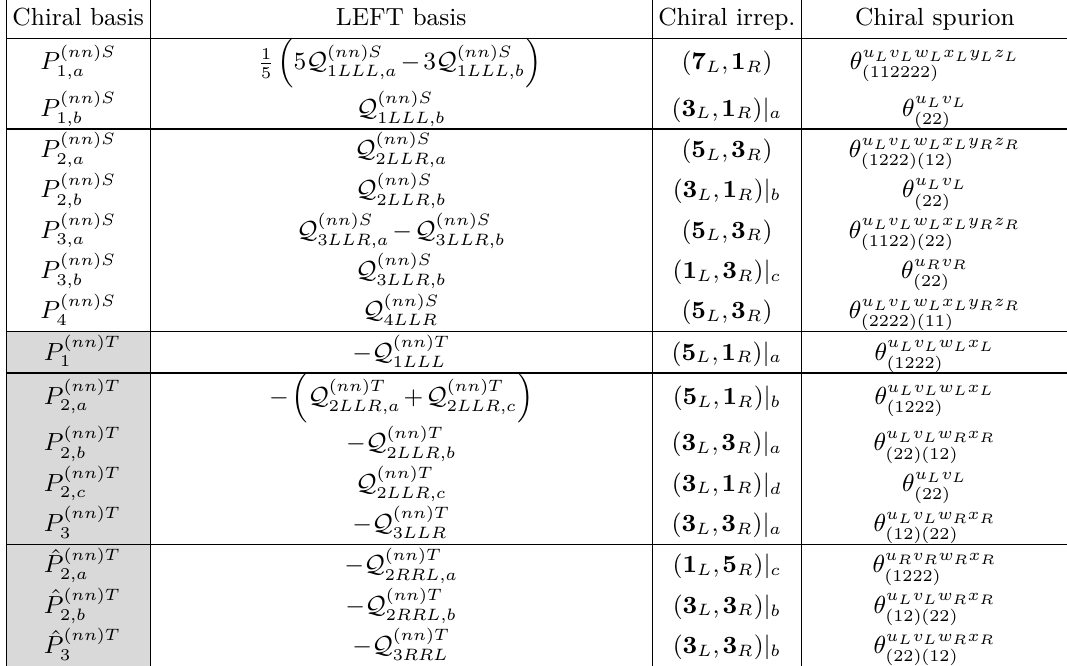
Table 7 . The chiral basis and their chiral irreps under G χ for the operators contributing to nn → ¯ ν ¯ ν 0